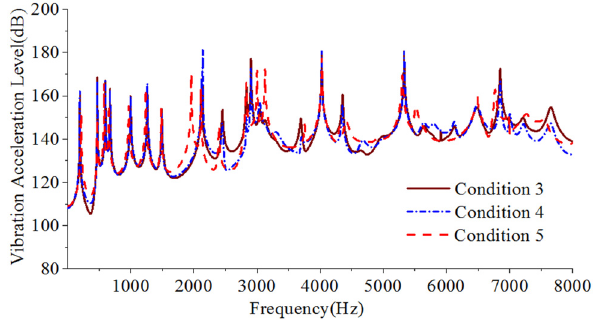
Figure 12: Finite element model.